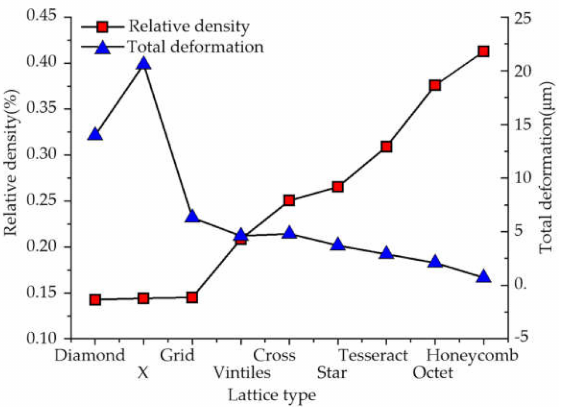
Figure 3. Relative density and compression deformation of different lattice